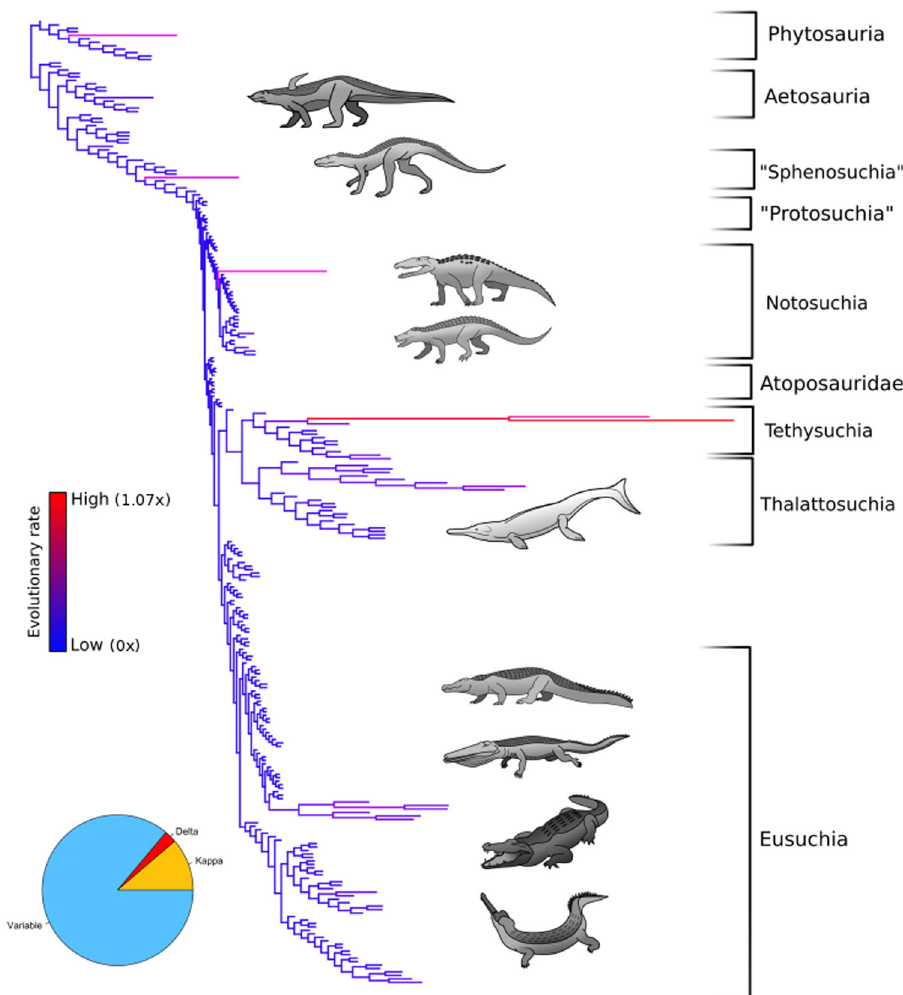
Fig. 1 Rates of body size evolution in the Pseudosuchia. Phylogeny of the Pseudosuchia with branch lengths set to indicate evolutionary rate. Long branches, shown in red, indicate high evolutionary rate. Short branches in blue indicate lower evolutionary rates. The rate scalars were output by a variable rate phylogenetic model implemented using